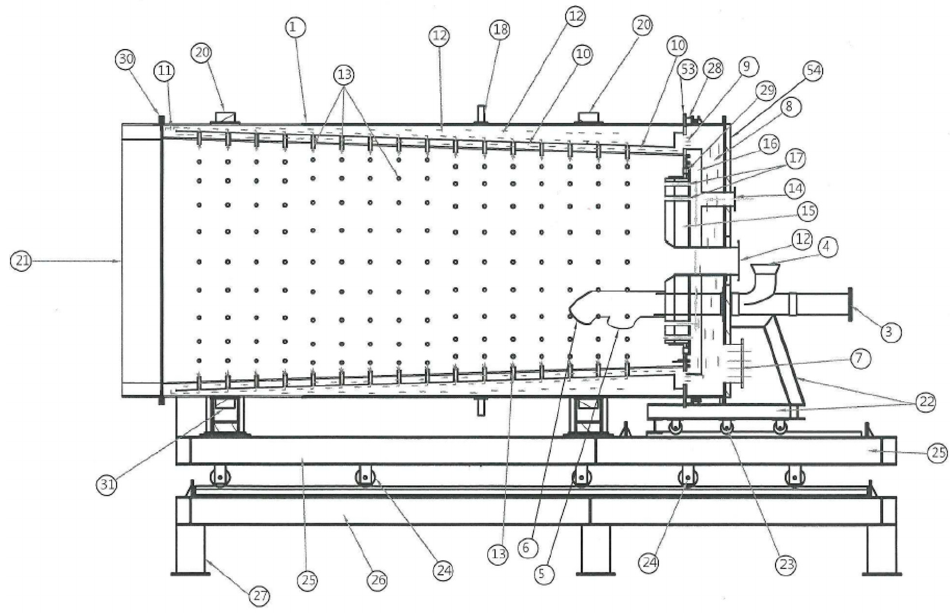
Figure 1. Patent no. KR101426660 B1.